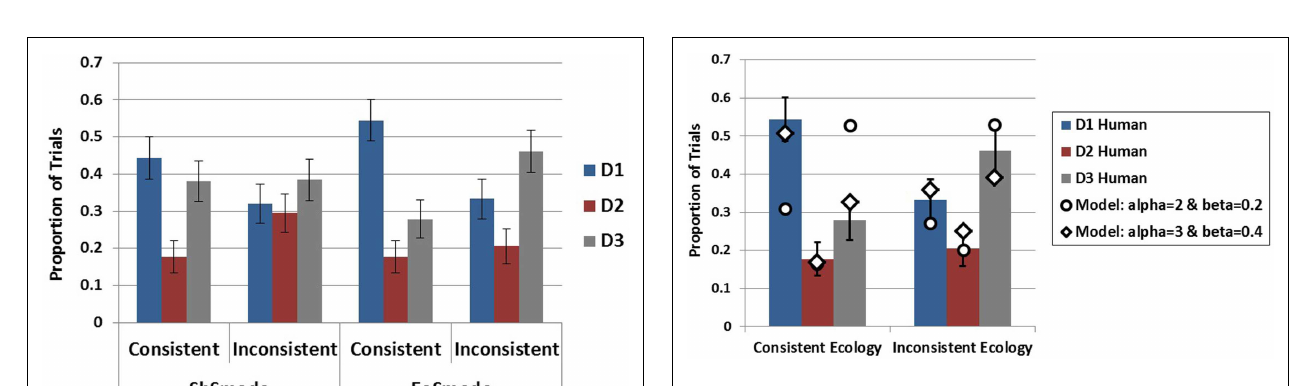
FIGURE 9 | Empirical data (bars) from Experiment 2 for the EoS conditions in both ecologies plotted with model data (diamonds and circles) at two levels of alpha and beta. Error bars represent standard errors of the